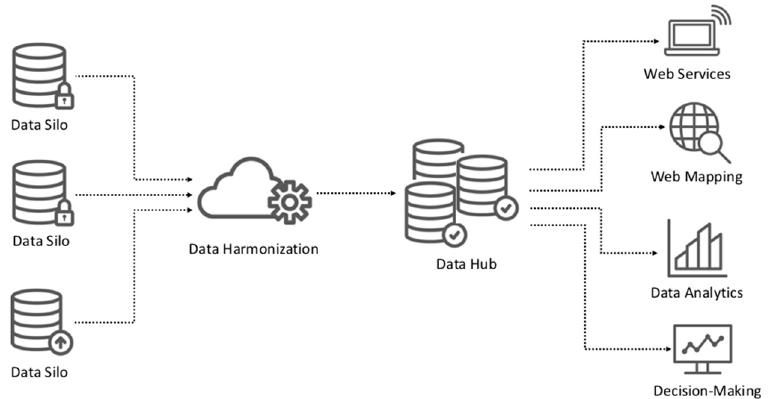
Figure 9. Data lake SDI architecture.